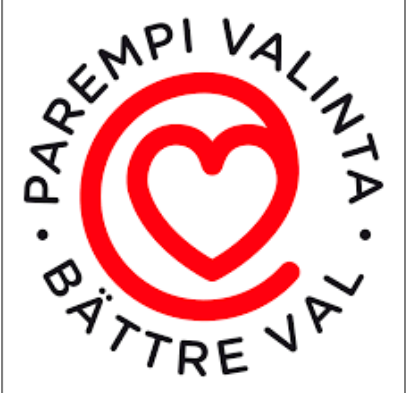
Figure A10. Heart Symbol (Finland) identifies options with a better nutrient profile in a given